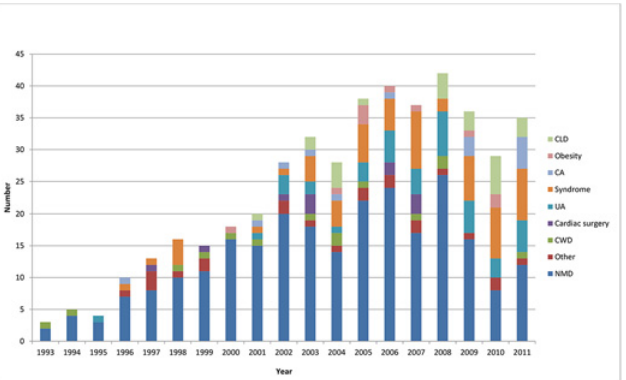
Fig 2. Patients initiated on ventilatory support by year and diagnosis. Fig 2 shows the number of patient ’ s initiated on ventilator support at our centre by year of initiation. It also shows the diagnosis group of the patient ’ s initiated each year. Note that over time the group diagnosis proportions change from predominantly neuromuscular disease (NMD) to include other such as chronic lung disease (CLD) and syndromes which include Trisomy 21. Central apnoea (CA), upper airway (UA) and chest wall disease